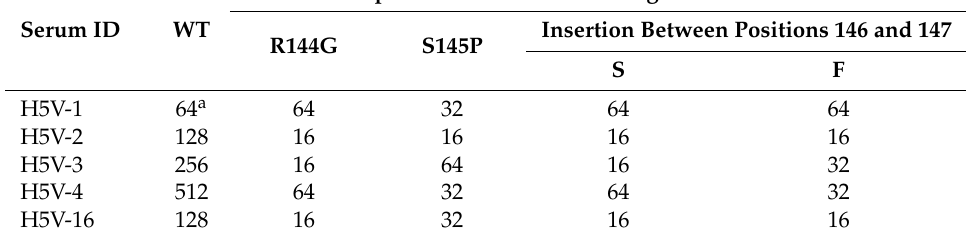
Table 10. Neutralizing activity of human sera isolated from volunteers who received the H5N1 pre-pandemic vaccine. Escape Mutant Virus Possessing the HA Mutation of Serum ID WT Insertion Between Positions 146 and 147 R144G S145P